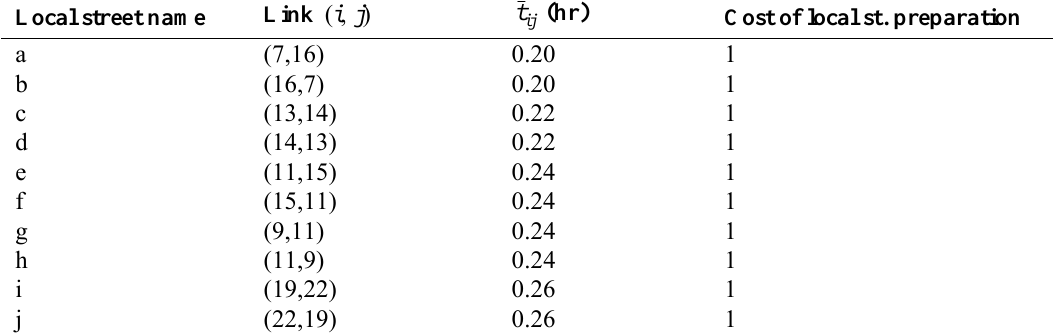
Table 7. Candidate local links for problem (AM) for the Example Network 2.